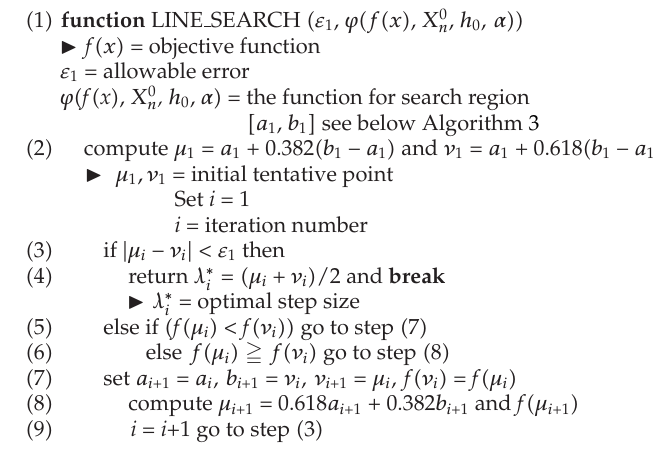
Algorithm 2: Line search algorithm.